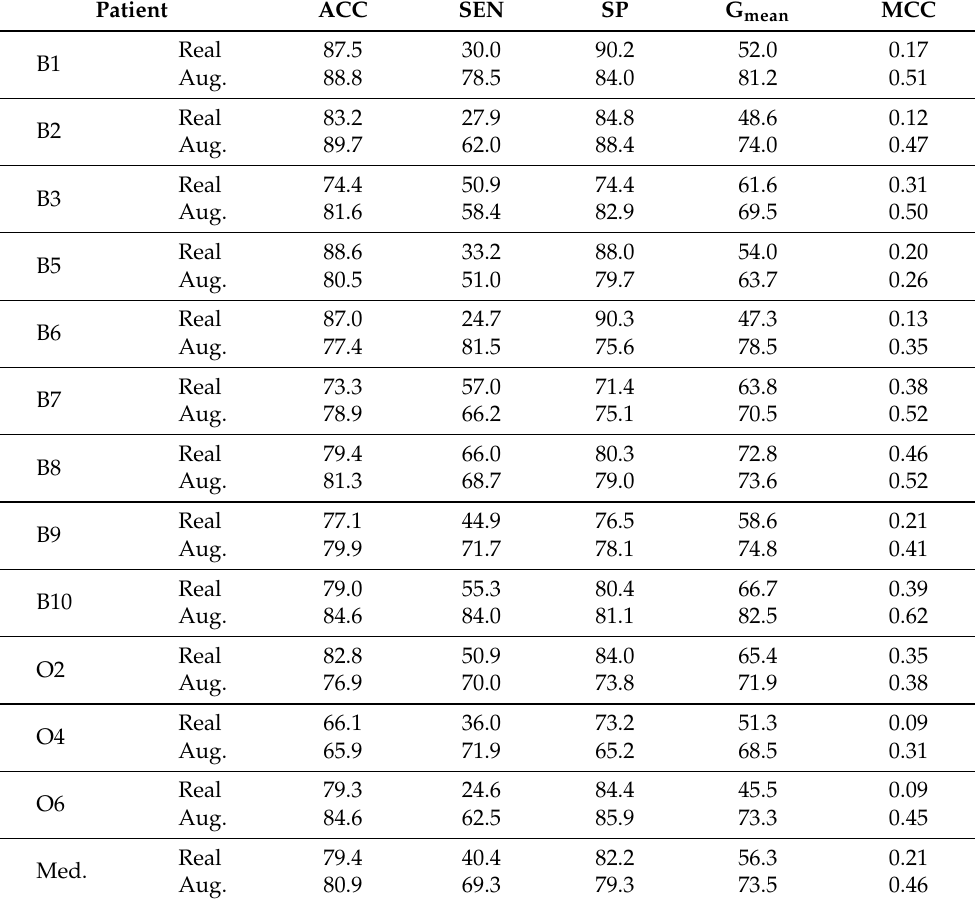
Table 7. Results of a nocturnal hypoglycemia classifier trained with real and augmented data sets for patients of both Barcelona and Ohio